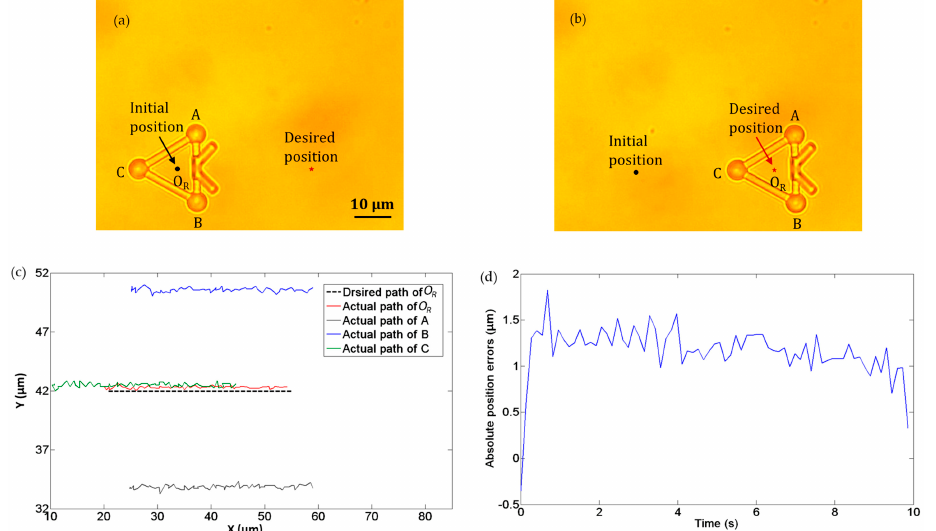
Figure 9. Experiments of translation movement of microtool. ( a ) Initial position. ( b ) Desired position. ( c ) Desired and actual transport paths. The black dotted line denotes the desired path of the microtool center O R , and the red line indicates the actual path of O R . ( d ) Absolute position errors of the microtool center O R in transport.